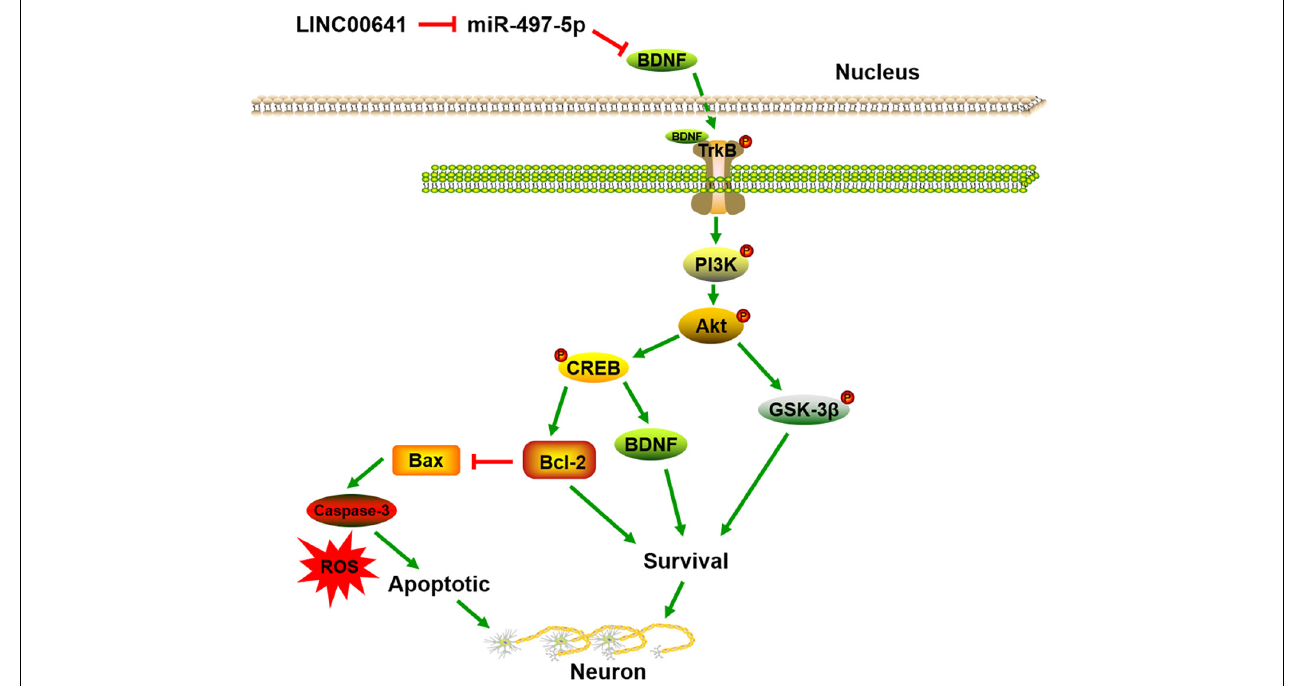
FIGURE 7 | LINC00641/miRNA/BDNF pathway diagram for ameliorating ketamine-induced neuronal